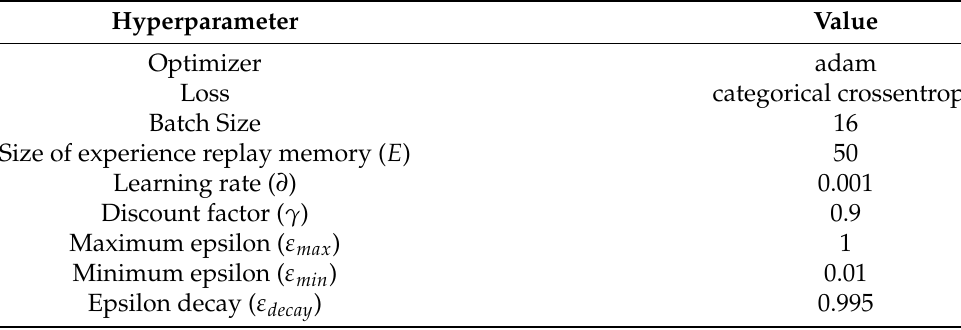
Table 4. Hyperparameters for LSTM-DQN-epsilon-greedy during